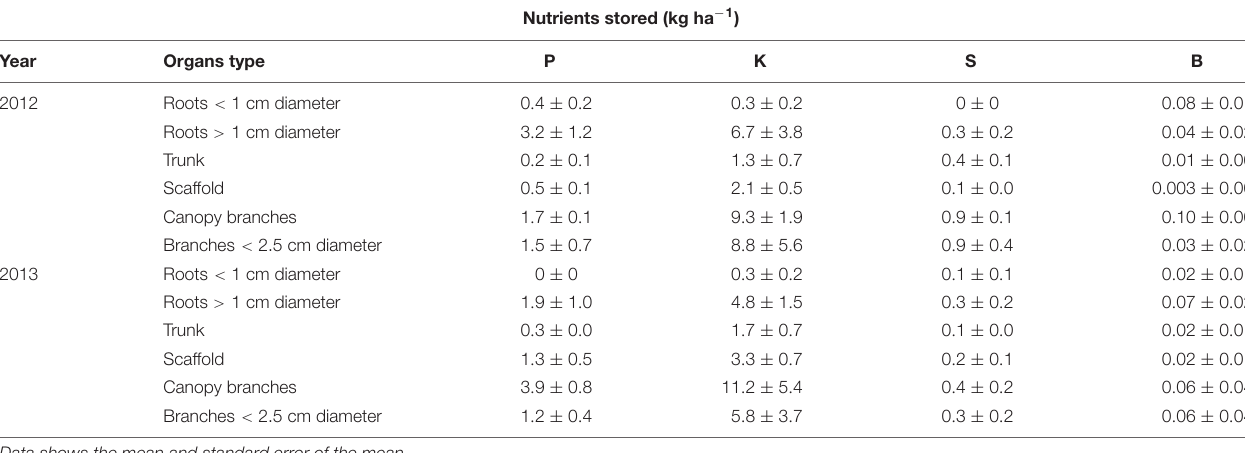
TABLE 6 | Phosphorus, potassium, sulfur, and boron storage (kg ha − 1 ) in tree perennial organs (nutrient content when tree is dormant minus lowest nutrient content in perennial tissue during season) for almond trees for 309 kg ha − 1 N application rate.